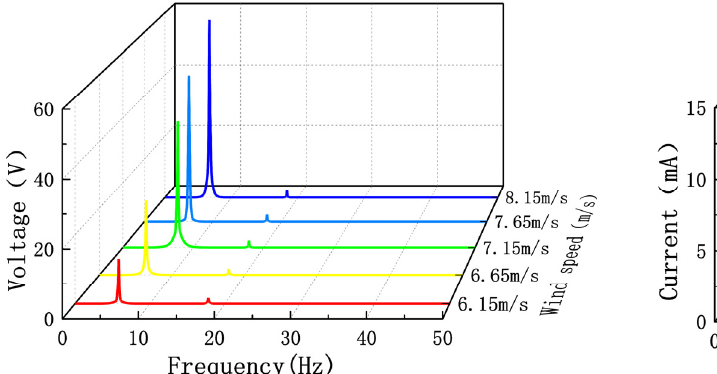
Figure 9. Output time-domain curve under different wind speeds before and after the jump at d 0 is 34 mm: ( a ) the PEH output voltage; ( b ) the EEH output current.